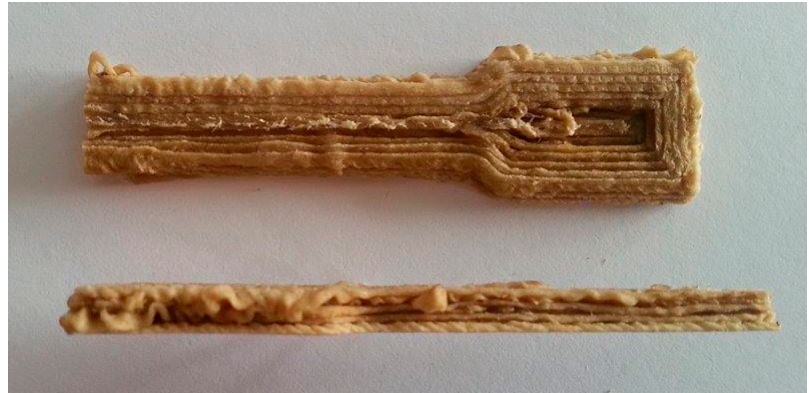
Figure 4. Uneven surface finish of 30 wt % hemp.